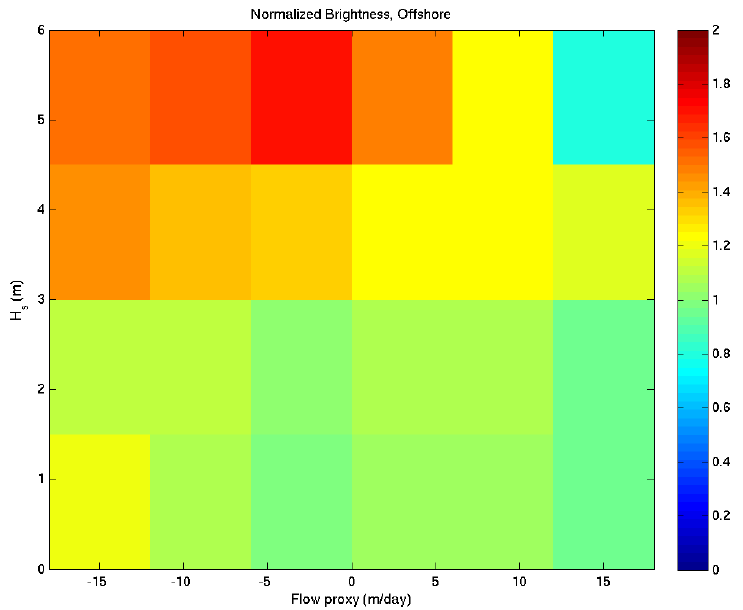
Figure 18. Normalized brightness of offshore sampling region as a function of wave height and tidal flow (proxy).